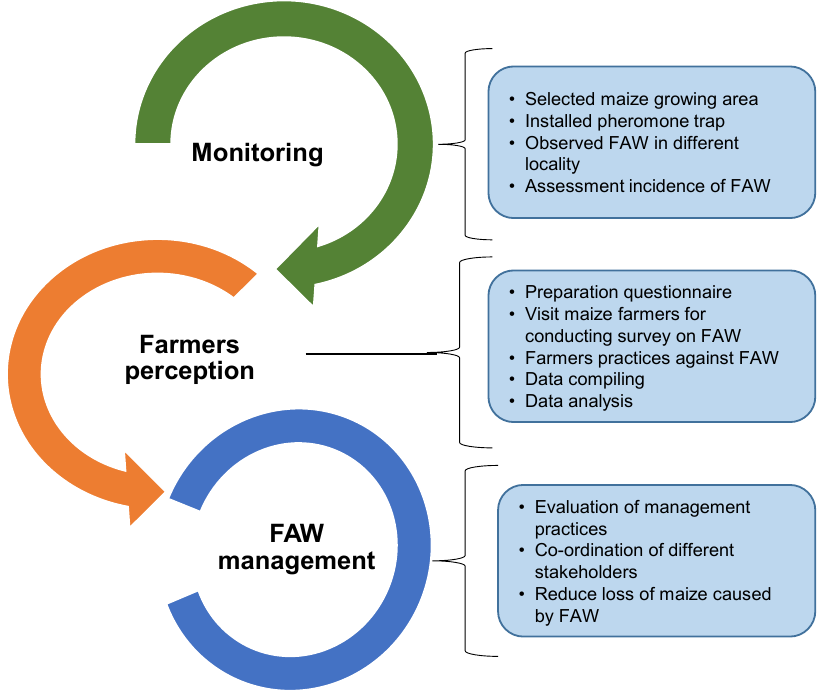
Figure 3. Outline of activities from monitoring to management of FAW.